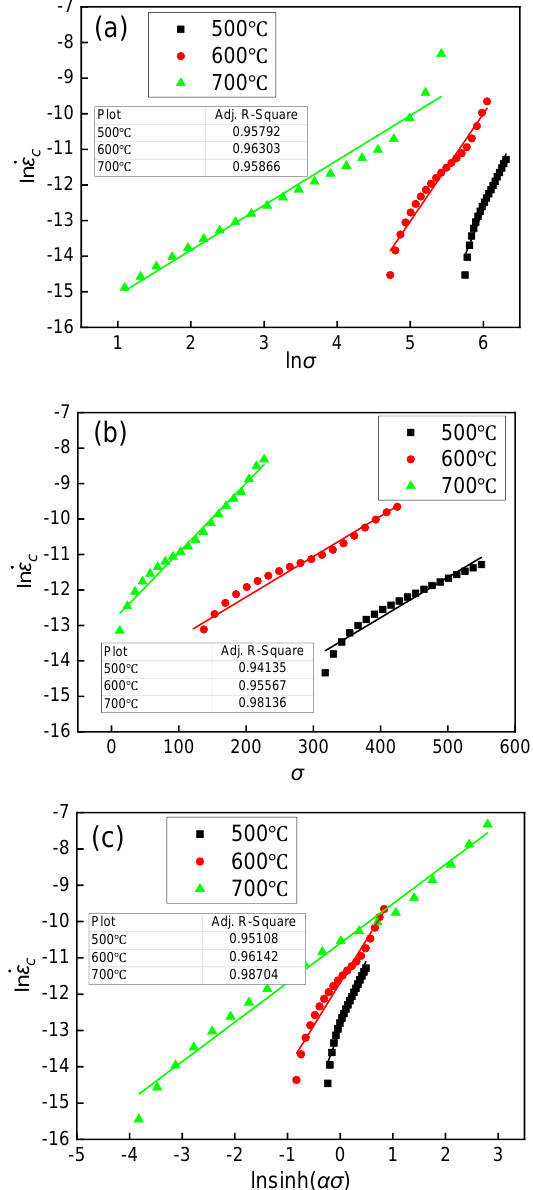
. . . ε c –ln σ ; ( b ) ln ε c – σ ; ( c ) ln ε c –lnsinh ( ασ )